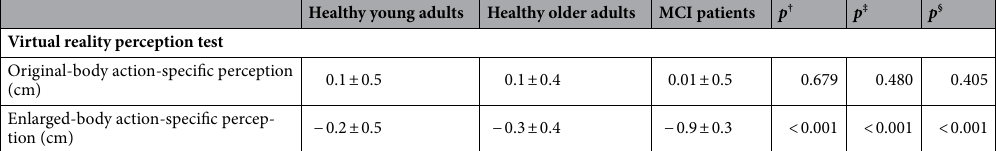
Table 2. The virtual reality perception test results by group. Values are expressed as means ± SDs. † ANOVA analysis, healthy young adults v. healthy older adults v. MCI patients. ‡ Post-hoc analysis, healthy young adults v. MCI patients. § Post-hoc analysis, healthy older adults v. MCI